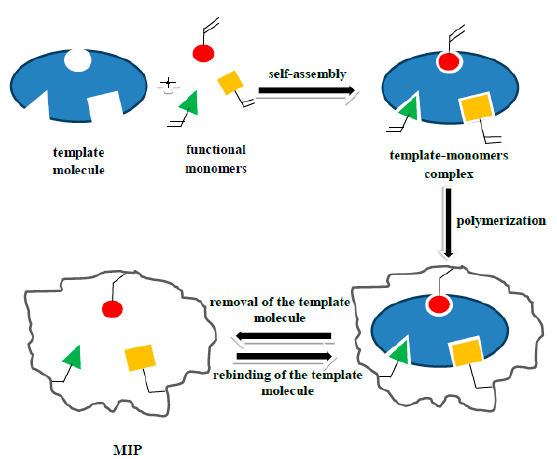
Figure 1. General scheme of obtaining MIP.